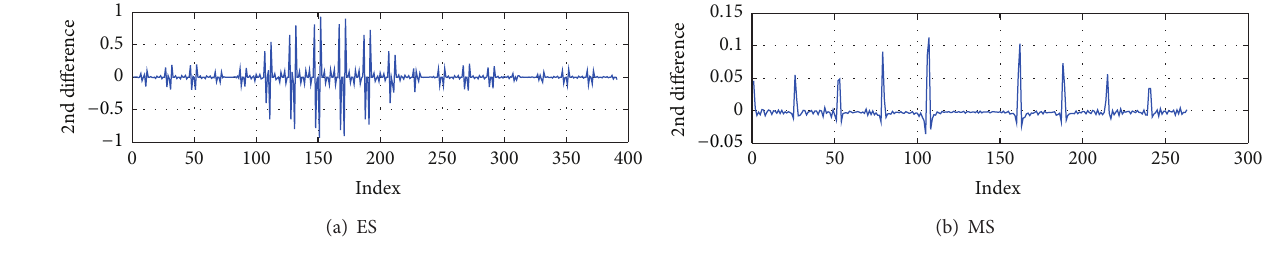
Figure 7: Second-order difference